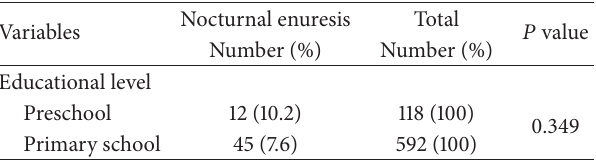
Table 3: Relationship between nocturnal enuresis and educational